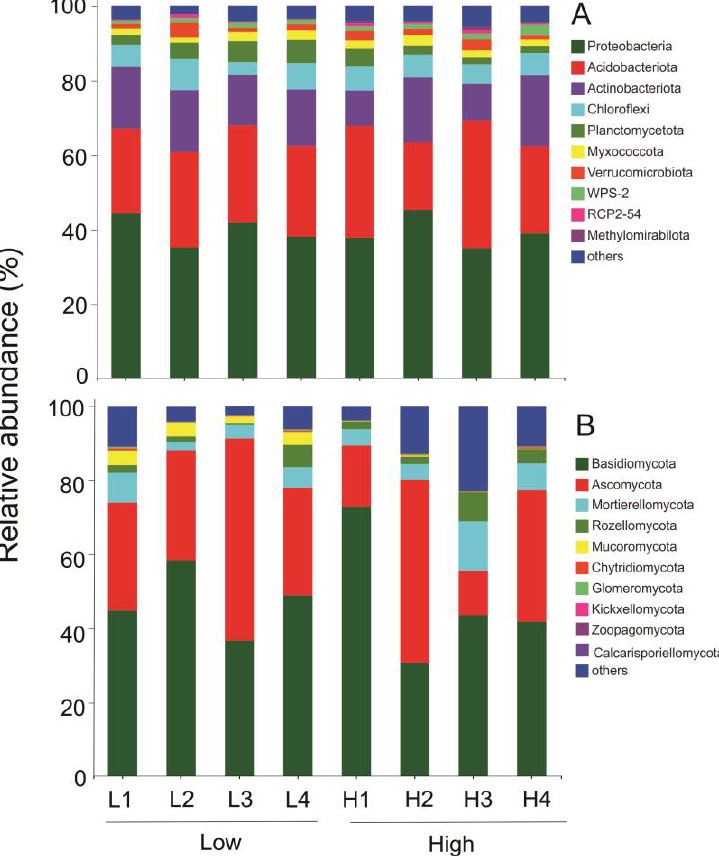
Figure 2. Relative abundances of top 10 microbial phyla: ( A ) bacteria and ( B ) fungi in soils at low and high elevation forests of Wuyi Mountain. L1, L2, L3, and L4 correspond to forests at low elevations and H1, H2, H3, and H4 correspond to forests at high elevation levels, respectively.